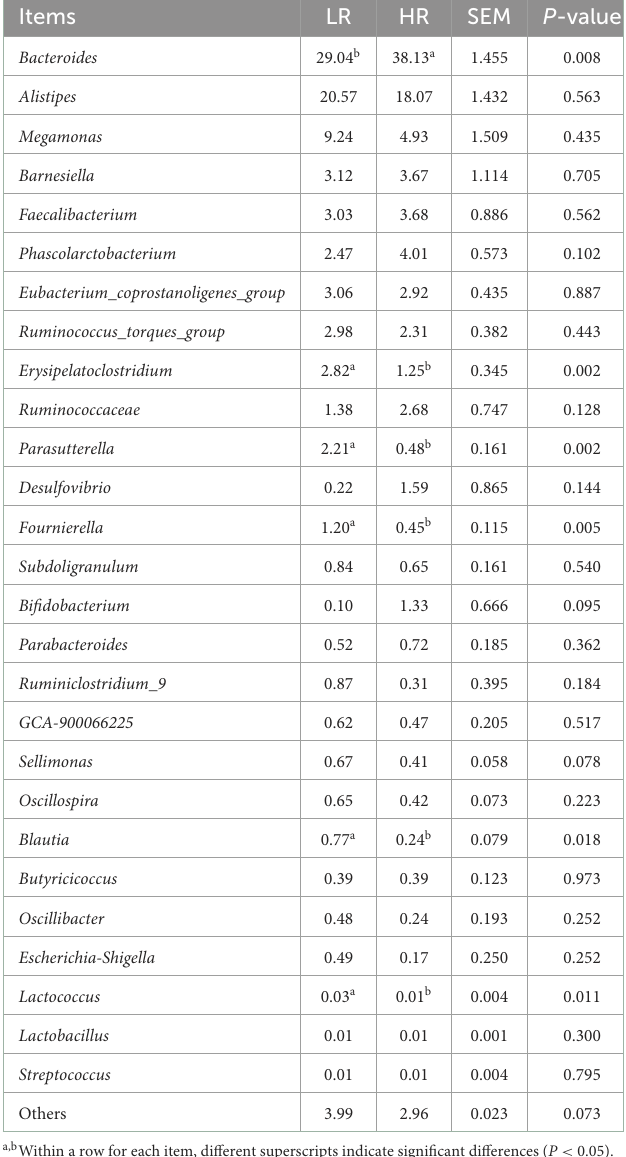
TABLE 4 Effects of RFI divergence on the relative abundances of small-sized meat ducks (%, level of phyla).